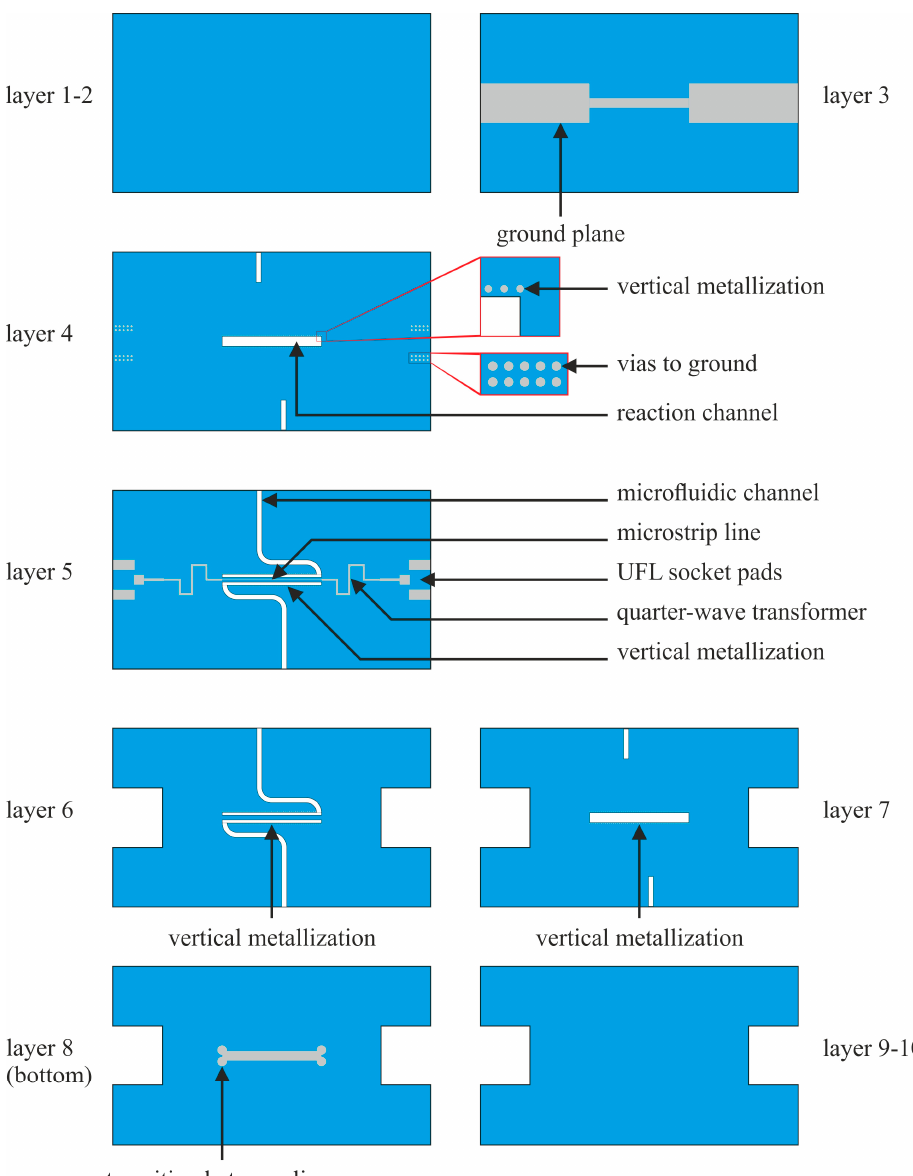
Figure 3. Design of the low temperature co-fired ceramics (LTCC) layers to construct the microfluidical microwave reactor.